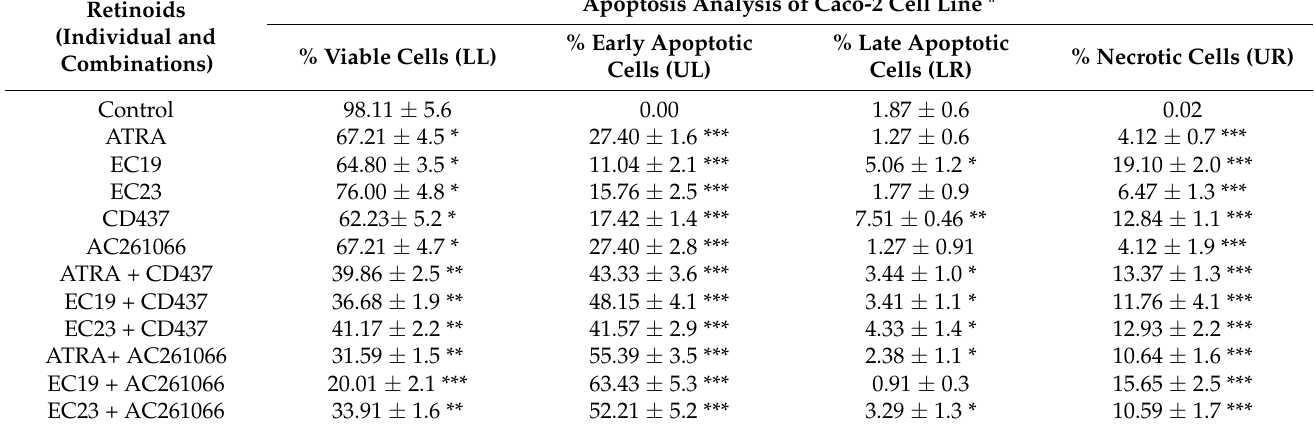
Table 2. The percentage of viable, apoptotic, late apoptotic and necrotic cells was measured by AV/PI assay using flow cytometry. The assay was performed after the treatment of Caco-2 cells for 24 h with ATRA, EC19, EC23, CD437, AC261066 and combinations with either CD437 or AC261066 compared to 0.1% DMSO negative control. Data represent mean ± standard error of the mean (SEM), n = 3.